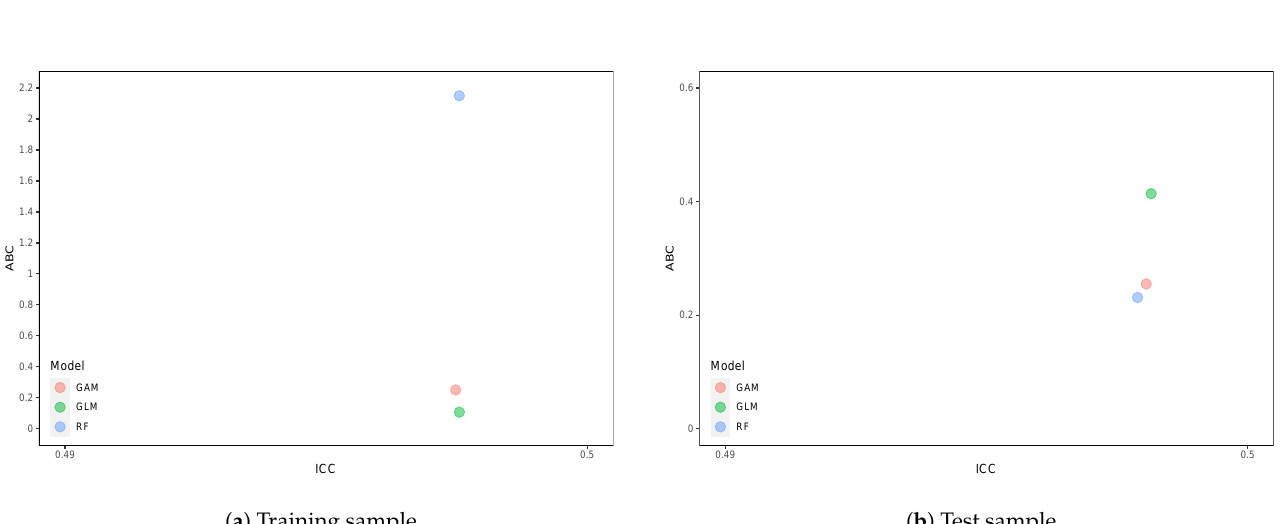
from the smoothing splines used. The optimized bins that are created by the evolution- ary trees and used in GLM are well visible along the age and horsepower variables